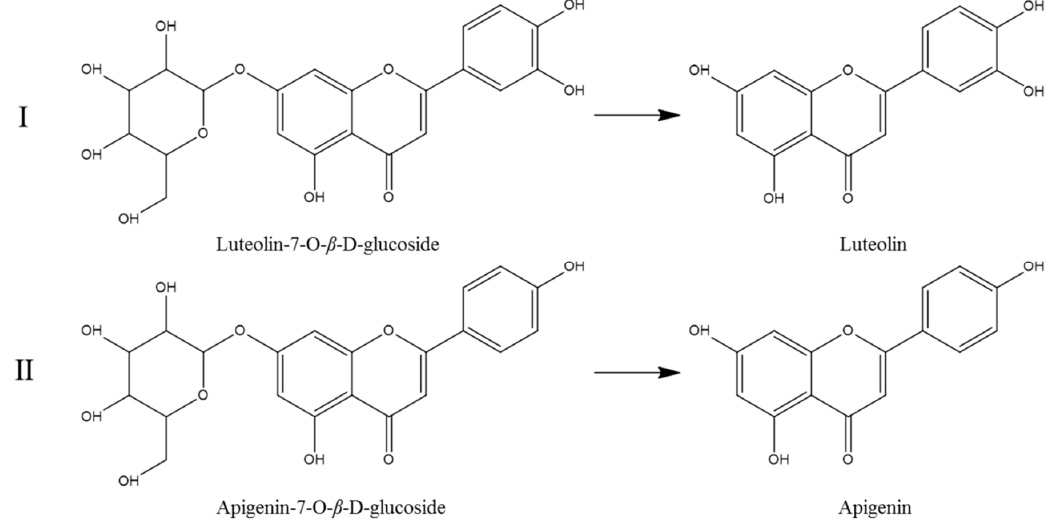
Figure 6. Possible mechanisms involved in the transformation of some main nonvolatile components during the stir-fry processing of SS.